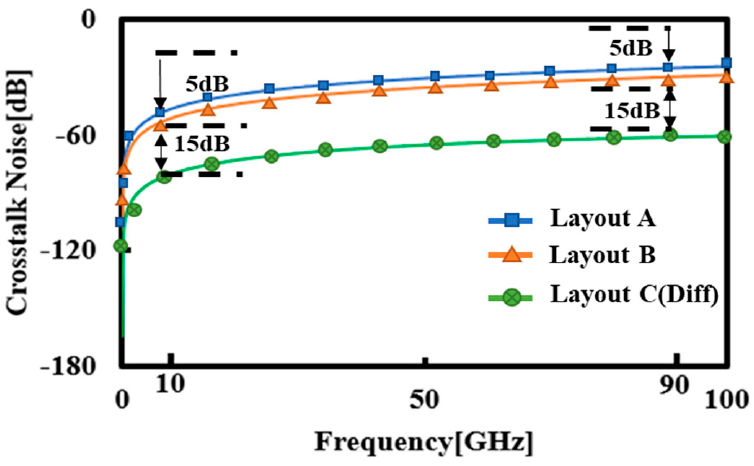
Figure 10. The crosstalk noise among layouts A, B and C(Diff).